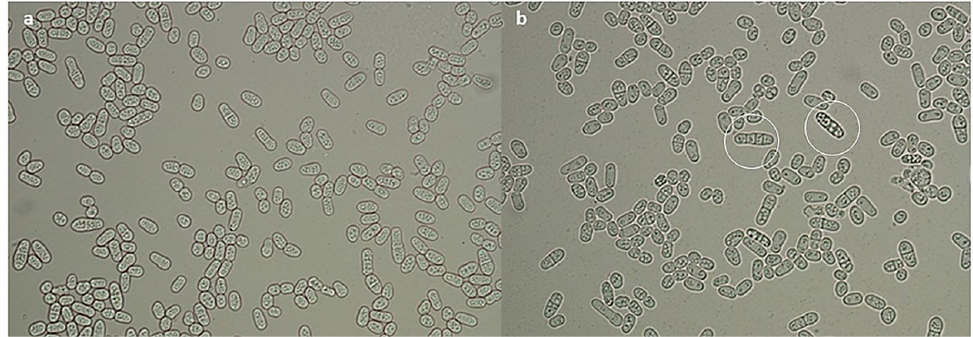
Figure 7. Morphology and division of S. pombe cells during cultivation in a culture medium: without pulcherrimin ( a ), with pulcherrimin ( b ). S. pombe cells show abnormal multiple divisions in the presence of pulcherrimin (white circles).